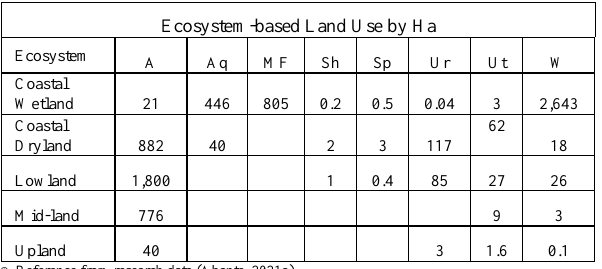
Figure 5. Montufar and Bingay Reefs have the largest ecological zone followed by Ponco, Calao and Ibingan subwatershed. Other